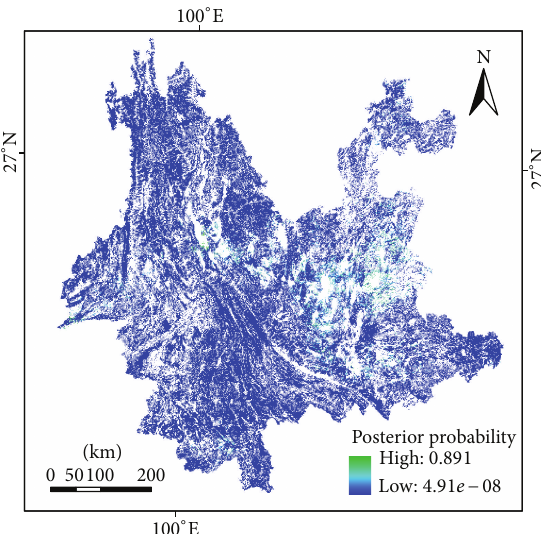
Figure 5: Posterior probability map of land use suitability.